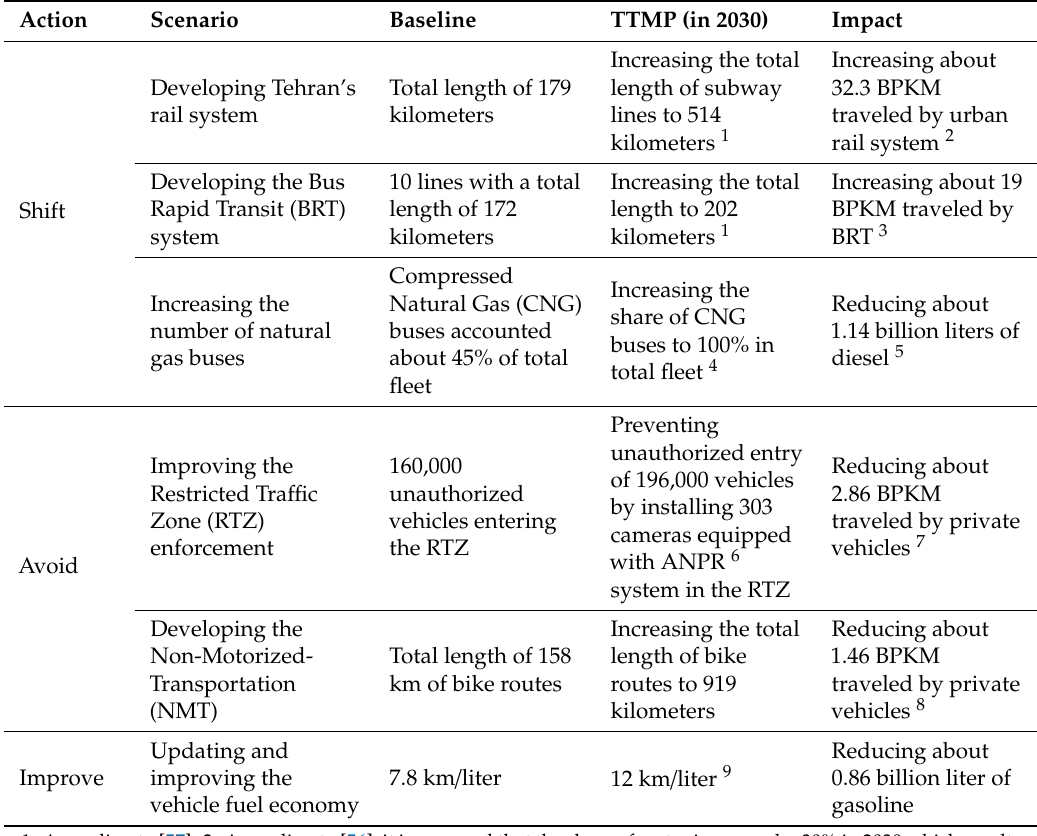
Table 7. The actions and initiatives of the Tehran Transportation Master Plan (TTMP) [56].